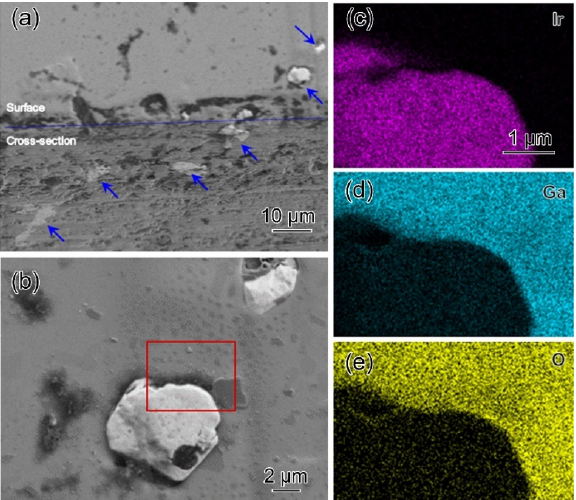
Figure 1. A photograph of a β -Ga 2 O 3 crystal containing the floating particles obtained using the CZ method. The inset shows the sample cut from the large β -Ga 2 O 3 crystal for characterization. The black rectangular and round boxes mark the positions of the sample and seed crystal in the single crystal, respectively.